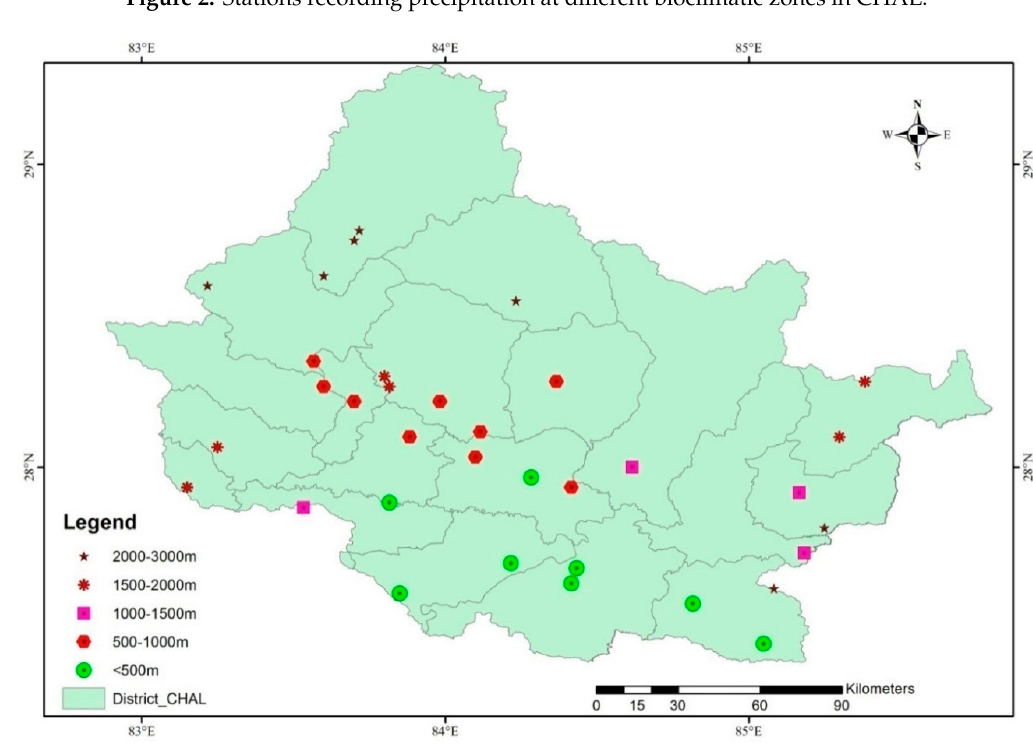
Figure 3. Temperature stations at different bioclimatic zones in CHAL .